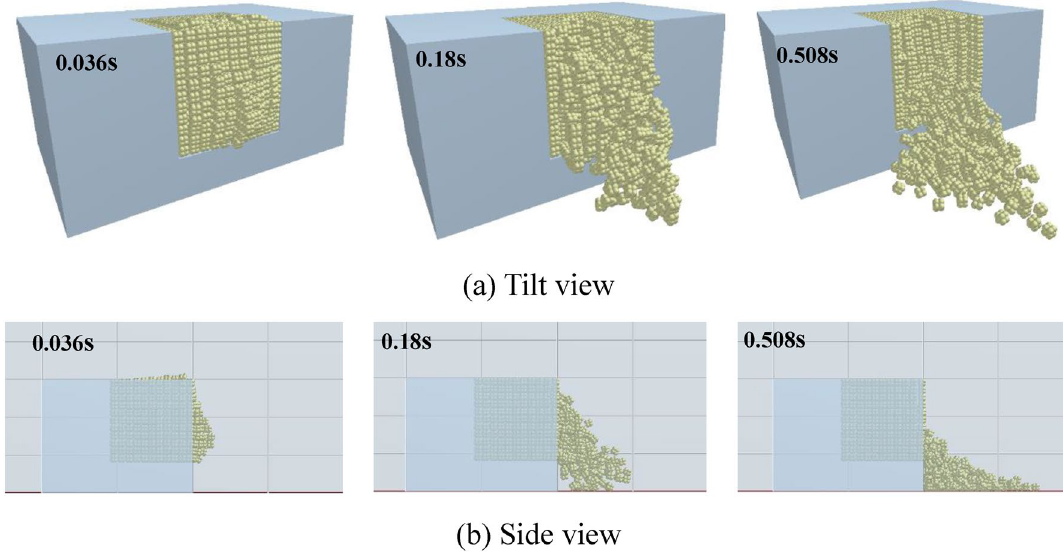
Figure 13. The motion of the blocks (0.6 g).